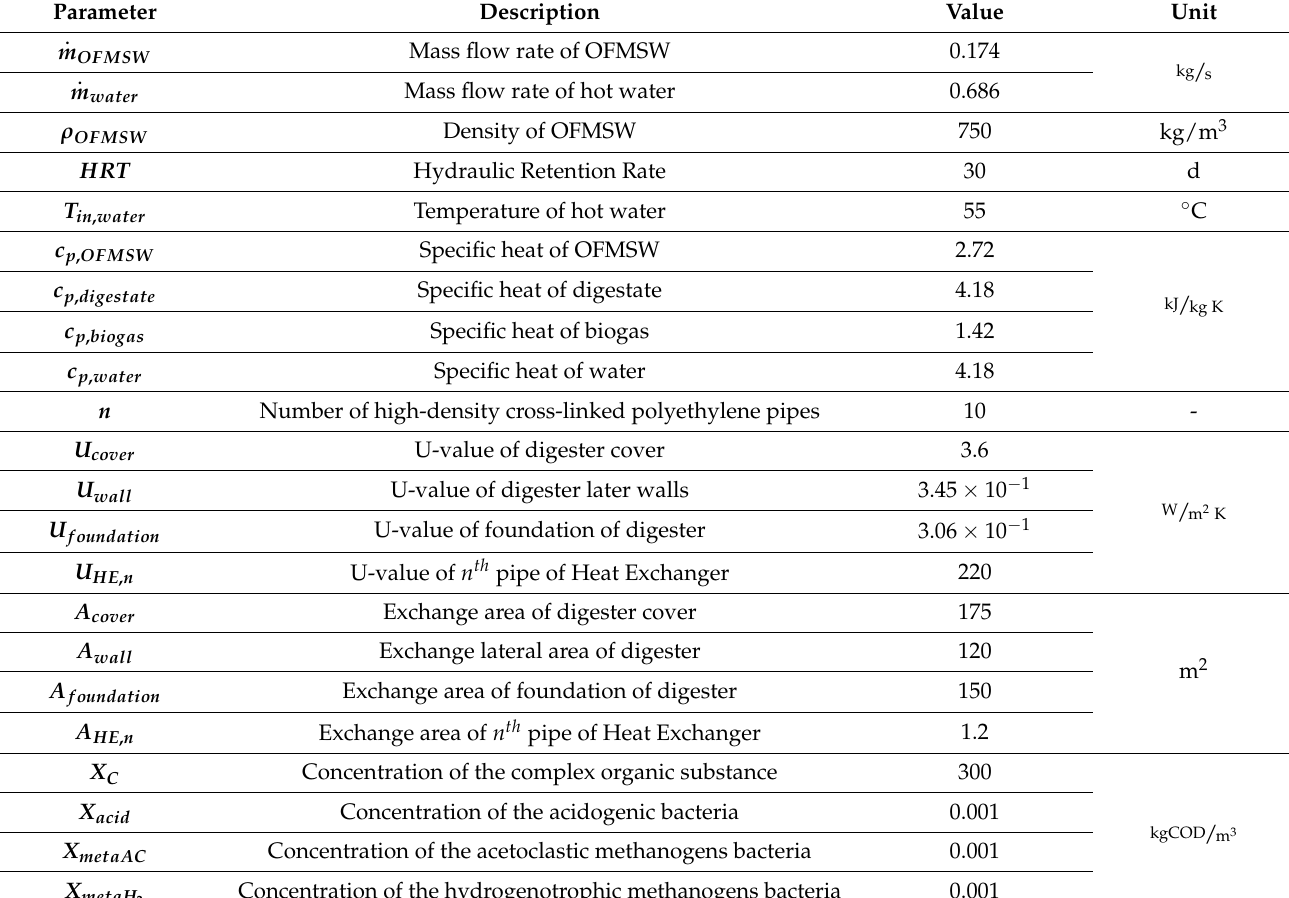
Table 3. Inlet parameters of the developed